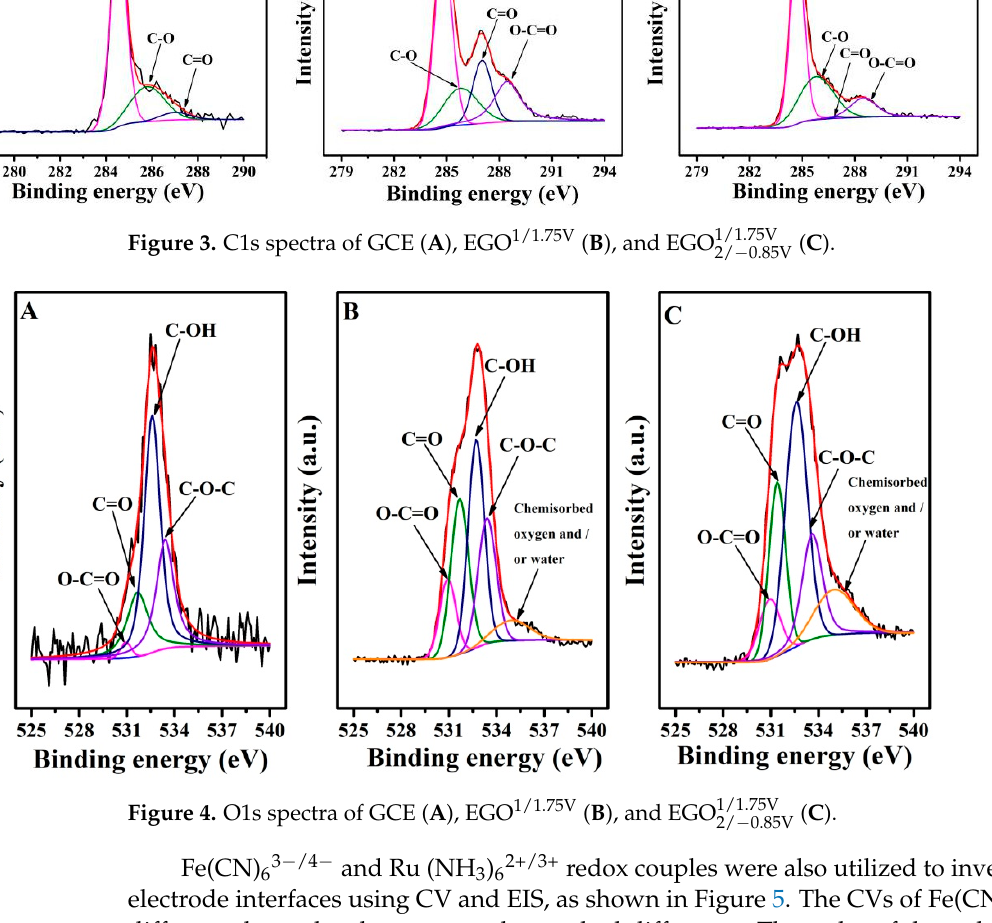
Figure 4. O1s spectra of GCE ( A ), EGO 1/1.75V ( B ), and EGO 1/1.75V Fe(CN) 63 − /4 − and Ru (NH 3 ) 62+/3+ redox couples were also utilized to investigate the